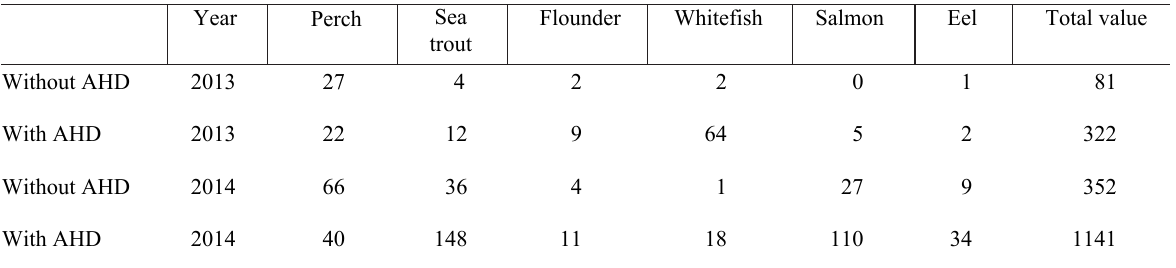
Table 5. Catch (kg) and its value (euros) of two fyke nets in 2013 (September) and 2014 (August–October) in locality Year Perch